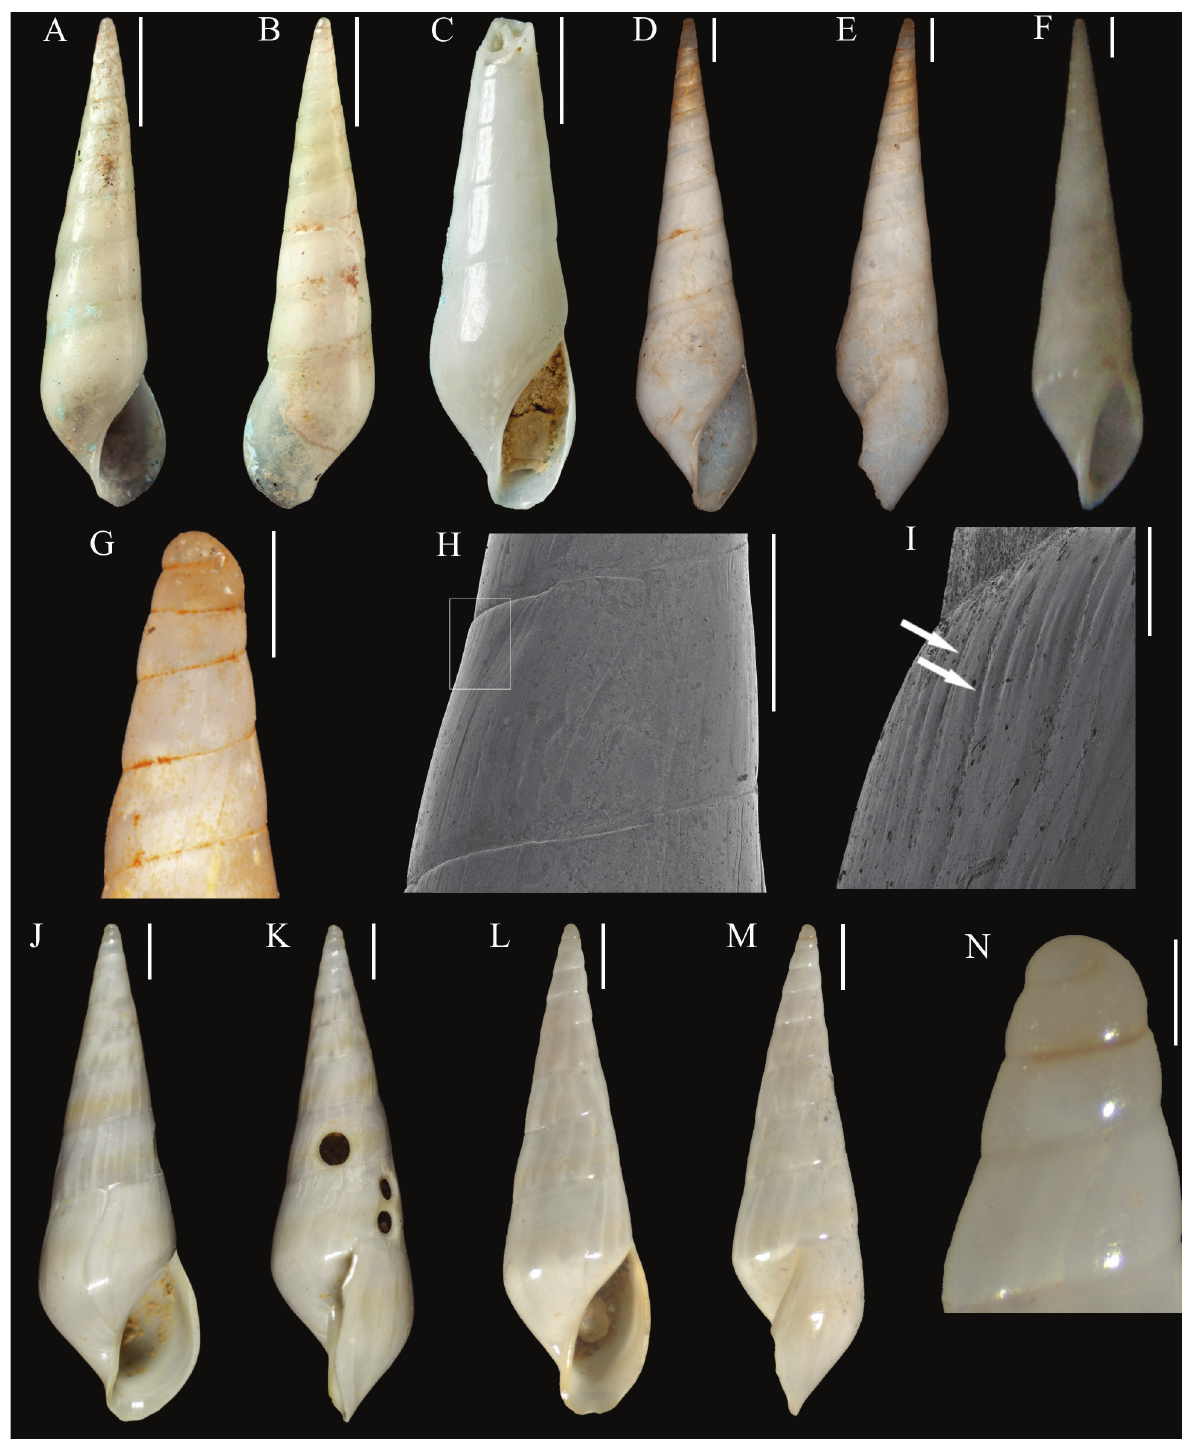
Figure 3. Eulimacrostoma spp. A–C. Eulimacrostoma chascanon (Watson, 1883), comb. nov.: A, B. Lectotype herein desig- nated (NHMUK 1887.2.9.1587); C. Paralectotype (NHMUK Norman Coll. 1979225); D–I. Eulimacrostoma fusus (Dall, 1889), comb. nov.: D, E, G–I. Lectotype herein designated (USNM 87273); G. Paralectotype (MCZ 7515). J–N. Eulimacrostoma lutescens (Simone, 2002), comb. nov.: J, K. Holotype (MNHN-IM 2000-5662); L–N. (MNHN-IM uncatalogued), from type locality. A, C–E, G, K, M. Shell in frontal view; B. Shell in dorsal view; F, L, N. Shell in lateral view; H, O. Detail of apical whorls in frontal view; I, J. Detail of teleoconch surface, white square in I indicates detail in J, white arrows in J indicates microsculpture of axial lines. Scale bars: 1 mm (A–G, I, K–N); 400 µm (H); 50 µm (J); 200 µm (O). Credits: A–C: NHMUK; H, I: USNM; J, K: